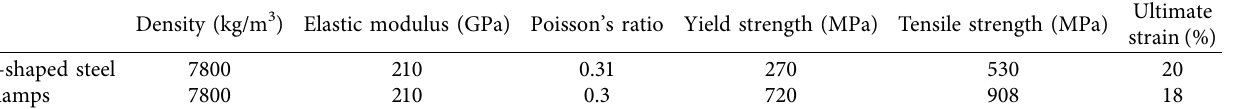
Figure 8: Pretightening force loading method of clamp. Table 1: U -shaped steel and card material parameters.